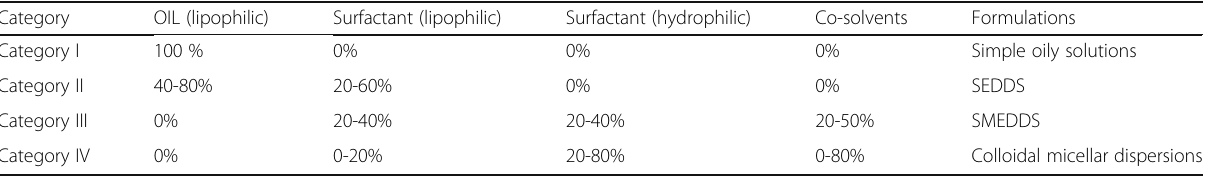
Table 1 Classification of LBDDS by